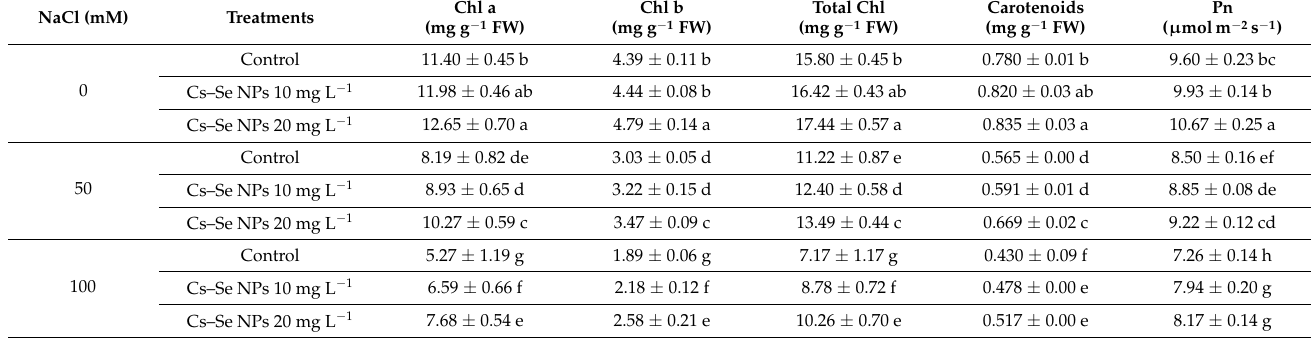
Table 2. Effect of foliar application of Cs–Se NPs (0, 10, and 20 mg L − 1 ) on photosynthetic pigments (Chl a, b, total Chl, and carotenoids) and net photosynthesis rate (Pn) of bitter melon ( Momordica charantia ) under salt stress (0, 50, and 100 mM NaCl). Data are the mean of 3 replications (n = 3) ± SD, statistically significant difference is given by letters according to the TMRT ( p <